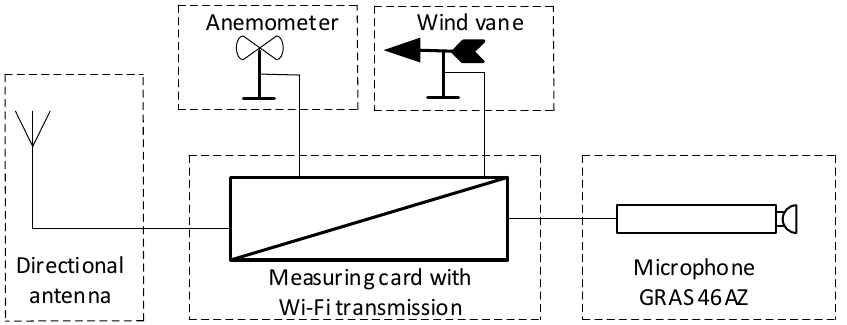
Figure 5. General diagram of measurement station of the INFRA system.